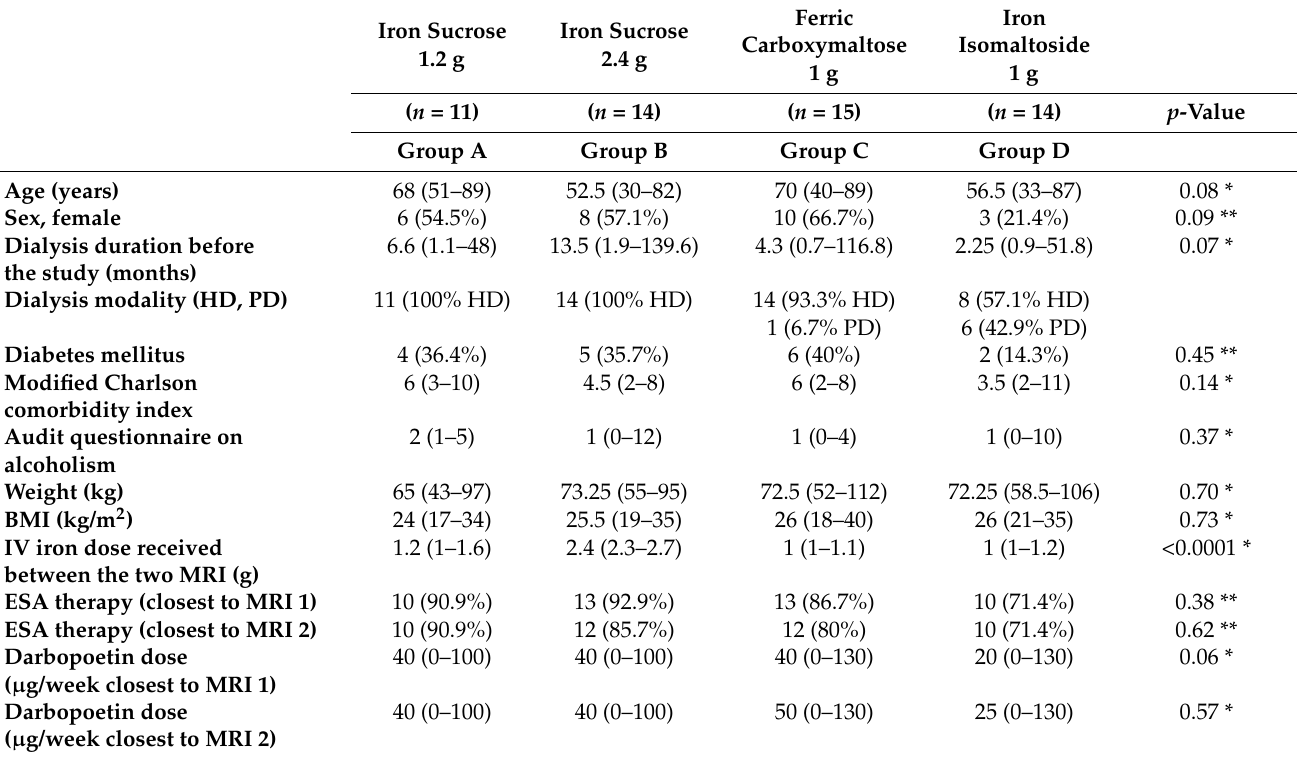
Table 1. Demographic and clinical characteristics of the study